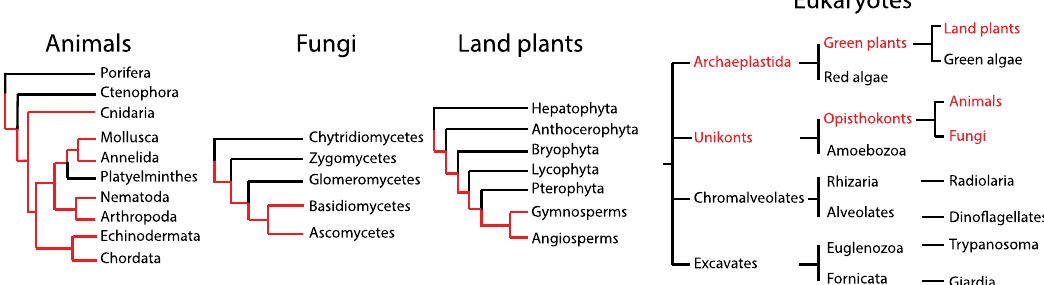
Figure 1. Presence of BAG-1 (red font) in eukaryotes based on BLAST results. Based on the parsimony criterion, BAG-1 may have originated before the major eukaryotic kingdoms split and was subsequently lost within individual taxonomic groups in each kingdom. Red lines represent the evolutionary history of the ancestral BAG-1. The relationships between the different taxonomic groups were obtained from the tree of life project (http://tolweb.org/Eukaryotes/3).